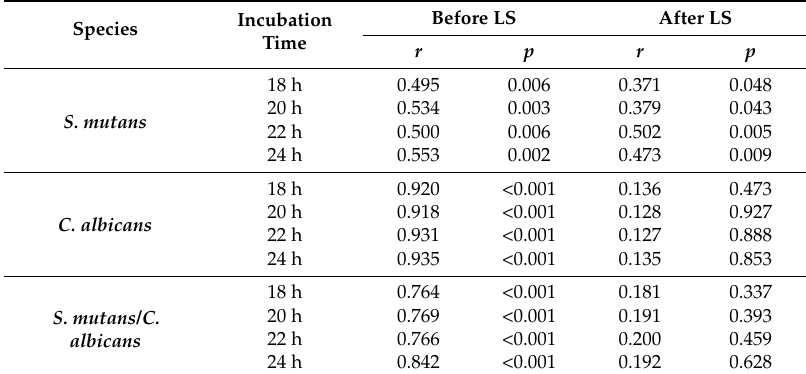
Figure 9. Correlations between the number of microorganisms forming a biofilm ( S. mutans ) (log(CFU/mL) and the optical density (biofilm mass) after 18 ( A ), 20 ( B ), 22 ( C ), and 24 ( D ) h of incubation, before Lactobacillus salivarius probiotic administration. Table 4. Correlations between the number of microorganisms forming a biofilm ( S. mutans , C. albicans , and S. mutans/C. albicans ) and the optical density (biofilm mass, OD) at different time points, before and after Lactobacillus salivarius (HM6 Paradens, LS)